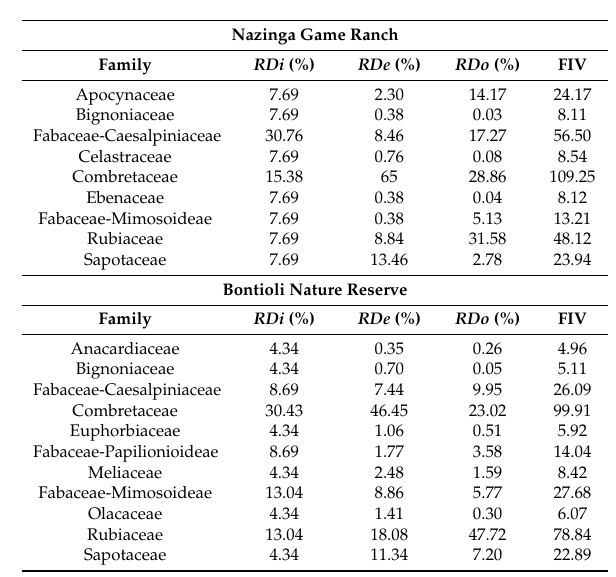
Table A3. FIV of Nazinga Game Ranch and Bontioli Nature Reserve. RDi (%) is the relative diversity of the plant family, RDe (%) is the relative density of the plant family and RDo (%) is the relative basal area of the plant